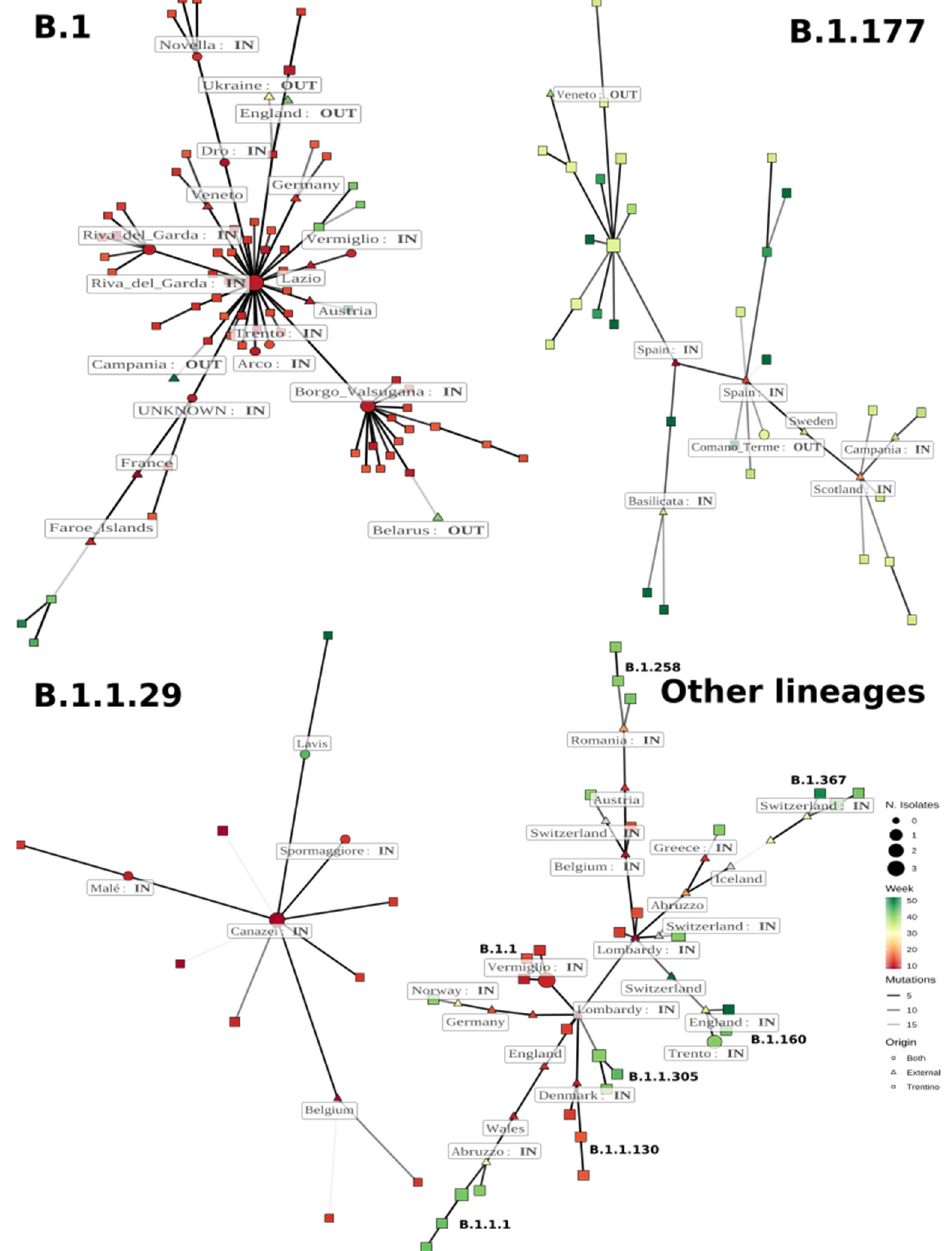
Figure 4. Minimum spanning network of the major lineages sampled from Trentino and other areas across the world. Nodes represent genomes, and the size of the nodes is proportional to the number of samples sharing that sequence. Edges connect two nodes if the most internal node has a subset of mutations from the external one. Colors represent the date of first sampling of each genome, and the transparency of the links is inversely proportional to the number of mutations differentiating the two connected genomes (lighter links correspond to a higher number of mutations). Different symbols represent the origin of the samples of each genome: only from Trentino (diamonds), only from outside Trentino (squares), or from both (circles). Nodes are labelled with the location of the first (in terms of sampling date) detection of a genome. Possible entry and exit points of the virus in Trentino are indicated as “IN” and “OUT”.